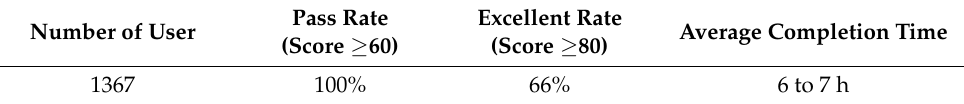
Table 7. Number of users and completion of experiment.